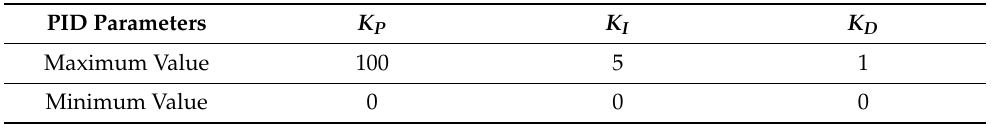
Table 2. The PID parameters band of ACO